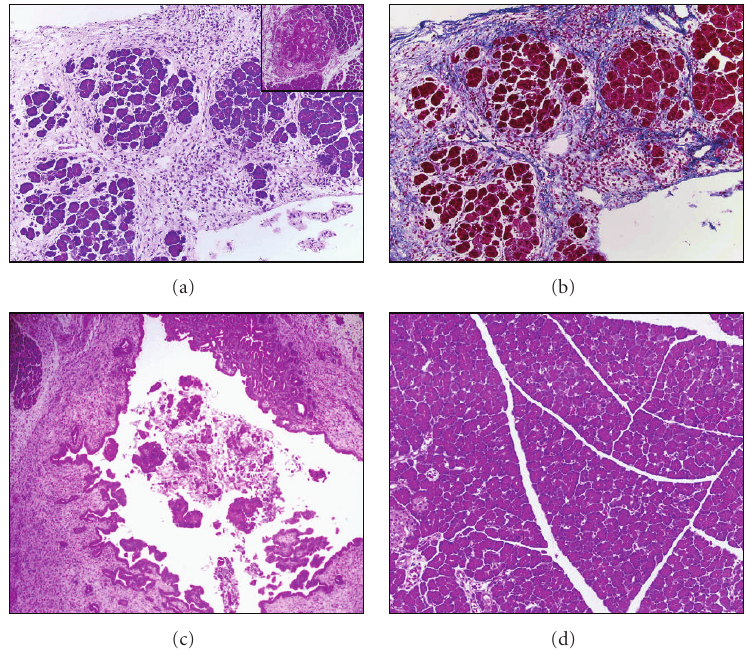
Figure 6: Representative light microscopic appearance of the pancreas in PDH and control groups on day 14 after the induction of PDH. (a) Pancreatic fibrosis was mainly distributed in the interlobular area with a nodular and lobular pattern. Marked infiltration of inflammatory cells was observed mainly in the interlobular area. Inset: representative light microscopic picture of focal fat necrosis. (b) Azan-stained section showed replacement of normal tissue by fatty and connective tissue. (c) Plug formation in the main pancreatic duct. (d) Minimal histological changes were observed in the control group on day 14. (Hematoxylin and eosin staining, original magnification ×